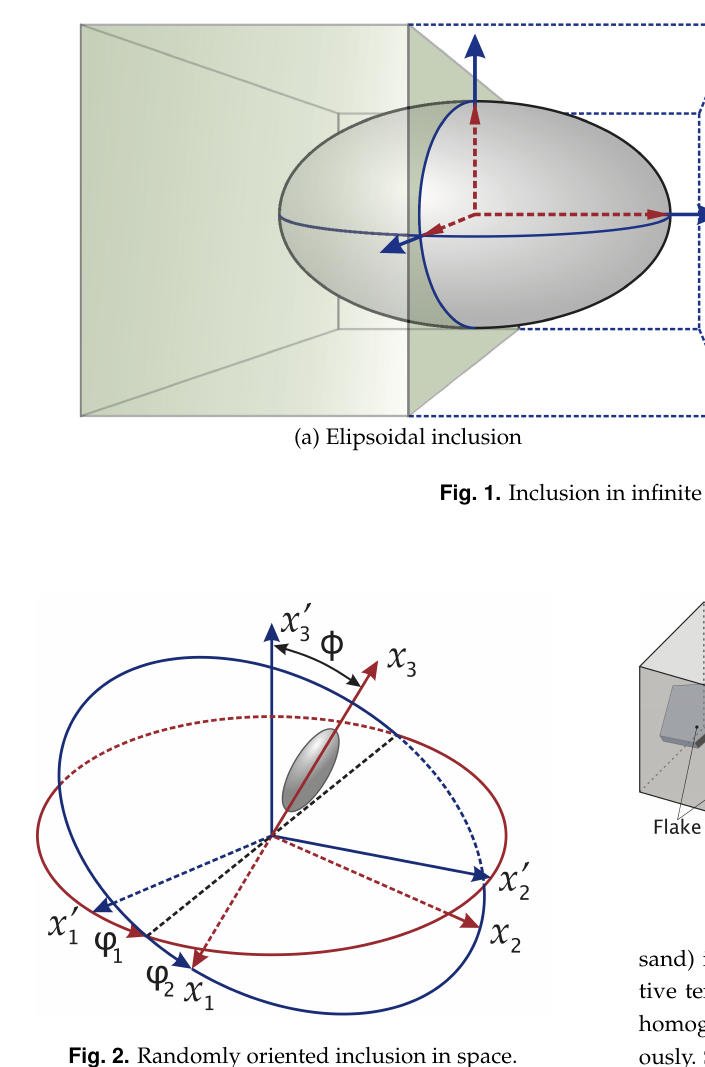
Fig. 2. Randomly oriented inclusion in space.